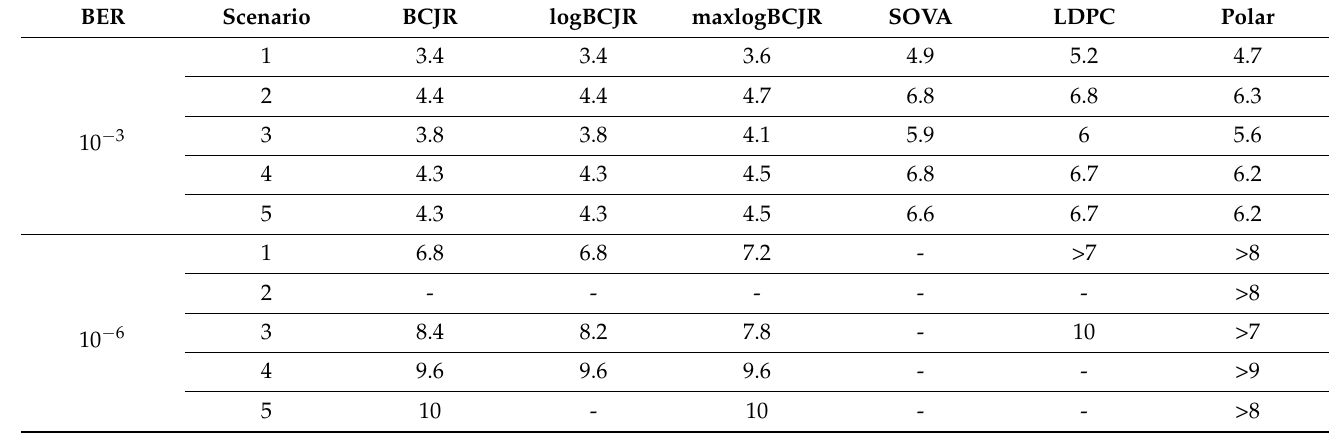
Table 7. SNR in dBs for BER values of 10 − 3 , 10 − 6 and 128-bit frame length.